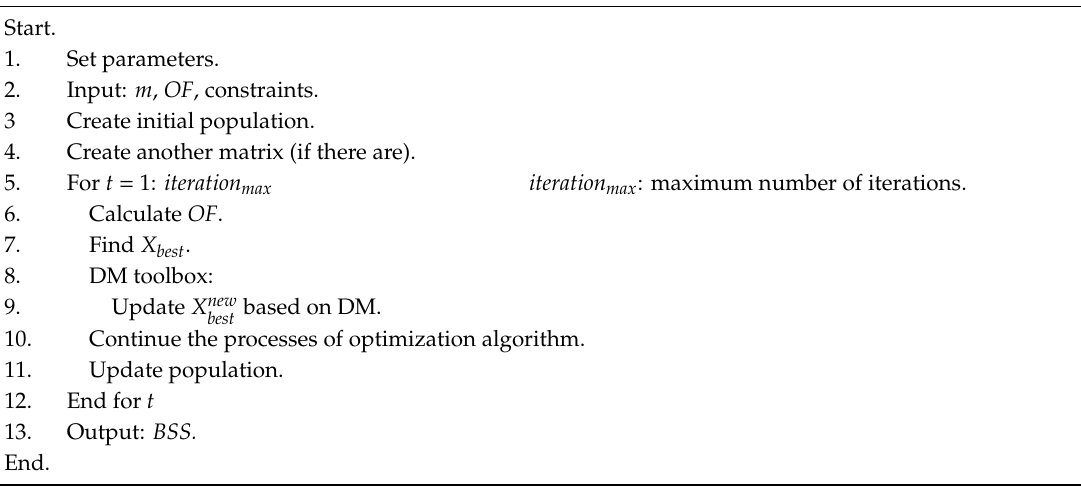
Algorithm 2. Pseudo code of implantation of the DM for modifying optimization algorithms